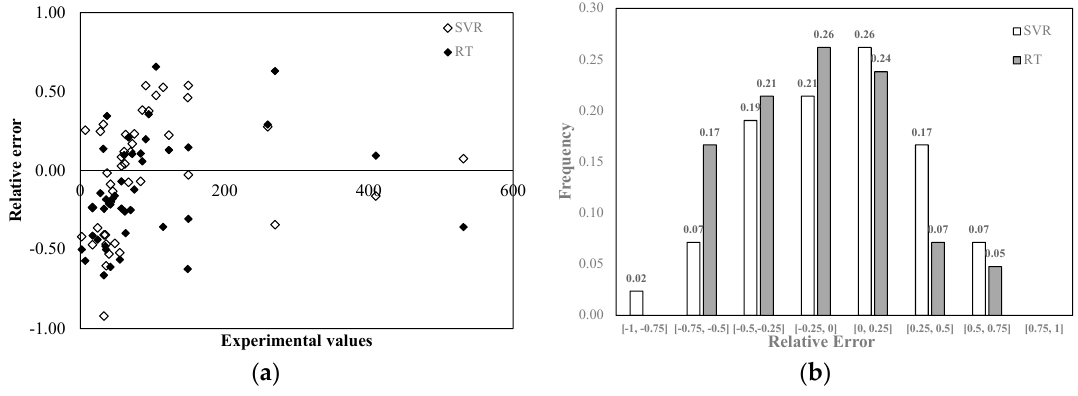
Figure 7. Distribution of errors in the COD predictions. ( a ) Relative error versus experimental values; ( b ) Frequency distribution.